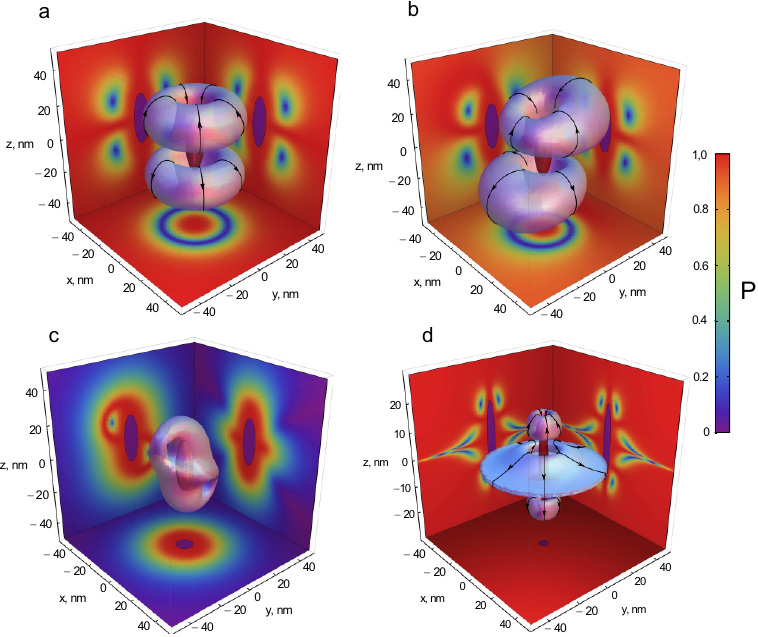
Figure 2. Distributions of the degree of polarization of the near field upon incidence of an external field that is linearly polarized along the z axis ( E 0, x = 0 V/m, E 0, y = 0 V/m, E 0, z = 200 V/m) in the case of a plasmon resonance α = α res . The three-dimensional surface corresponds to a value of P = 0.8. The two-dimensional distributions describe the cross sections in three planes: xz , yz , and z = 15 nm (in cases ( a , b )) and xy (in cases ( c , d )). The red color corresponds to the linear polarization ( P = 1), while the violet color corresponds to the circular polarization ( P = 0). The direction of rotation of the vector E is shown by